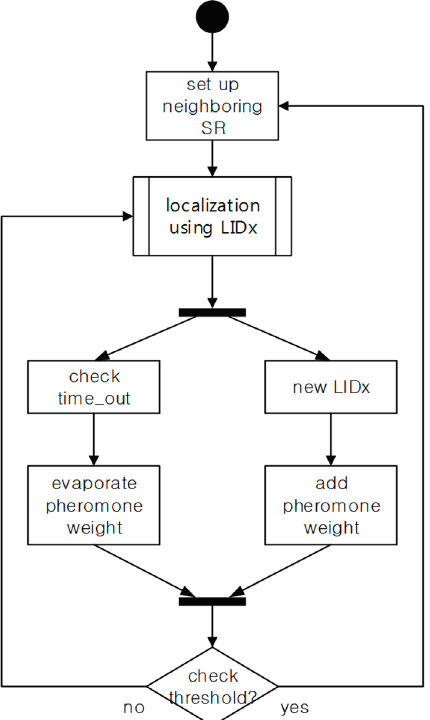
Figure 10. The state diagram from the update process for the pheromone